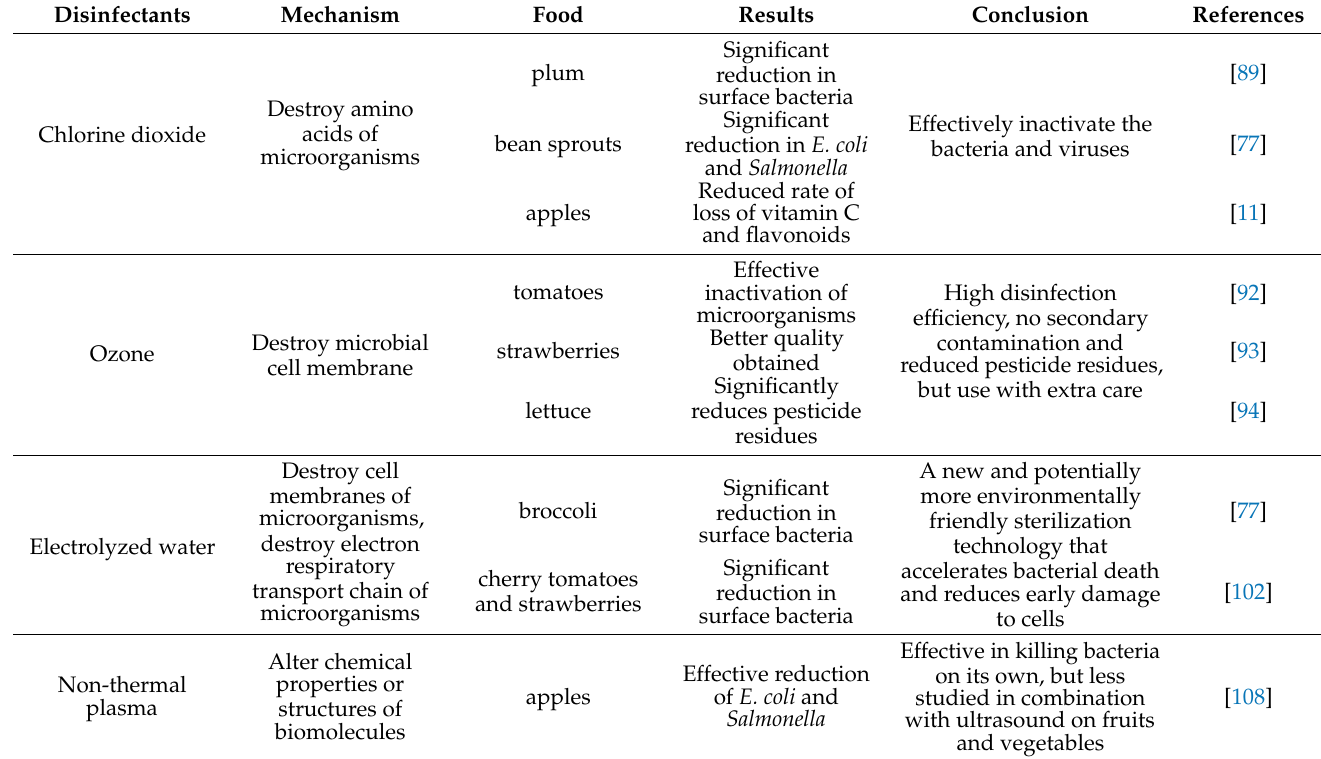
Table 2. Characteristics of disinfectants for ultrasonic